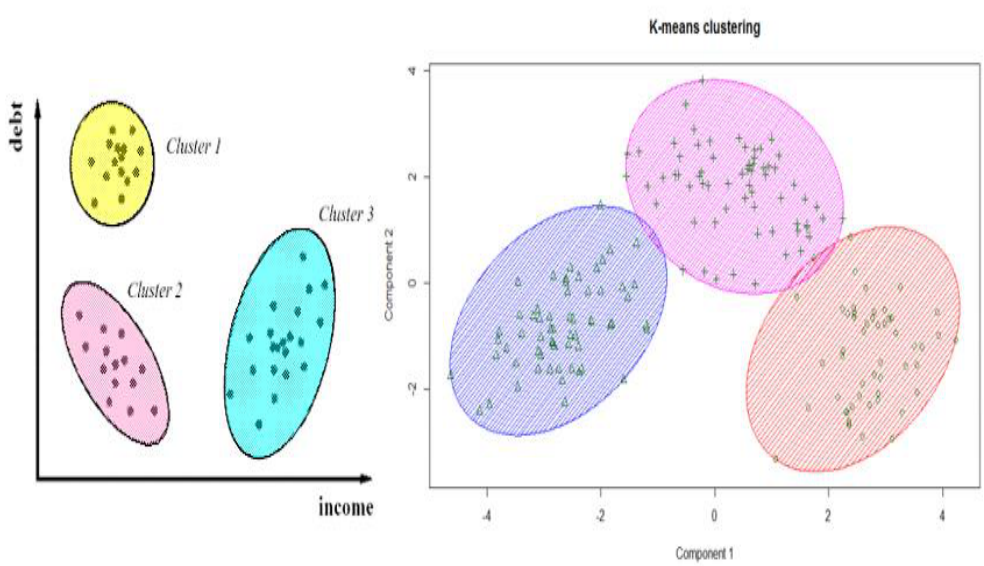
Figure 3. clustering in more